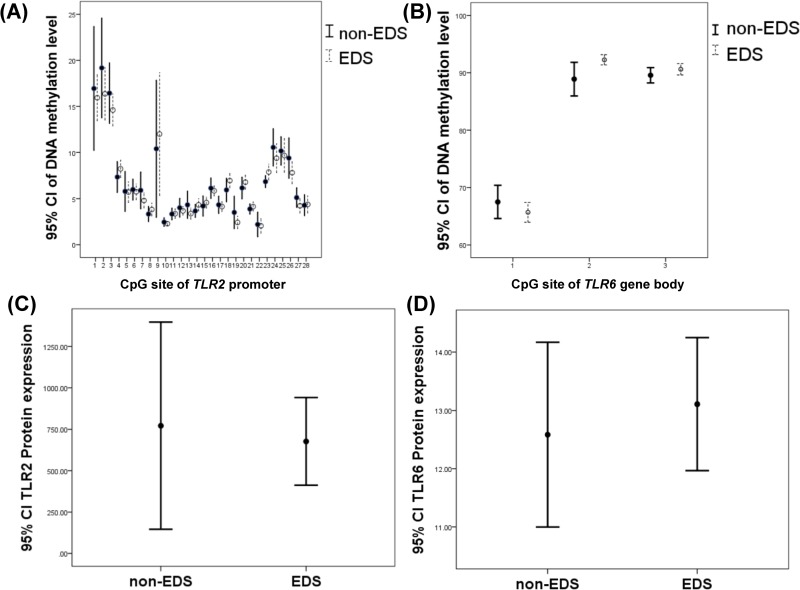
Comparisons of DNA methylation levels over the TLR2 promoter region, TLR6 gene body, and protein expressions of TLR2 and TLR6 between non-EDS and EDS groups.(A)~(D) The DNA methylation levels over the TLR2 promoter region, and protein expressions of TLR2 and TLR6 were not significantly different except that CpG site #2 of the TLR6 gene body was hypermethylated significantly in the EDS group (p = .032).